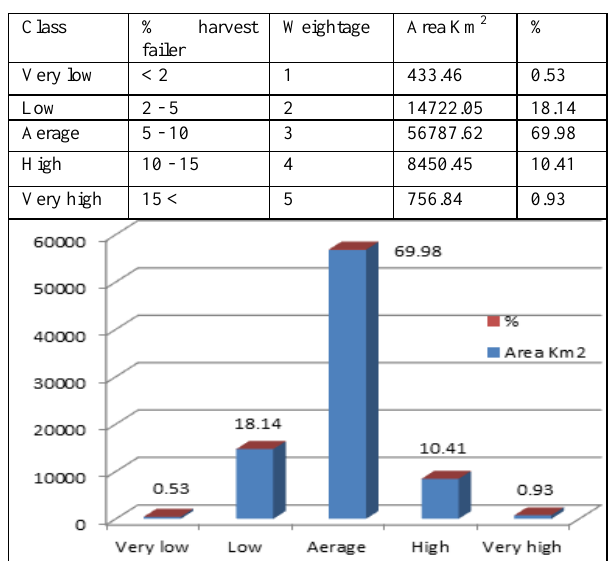
TABLE 10. Classification of harvest failure.